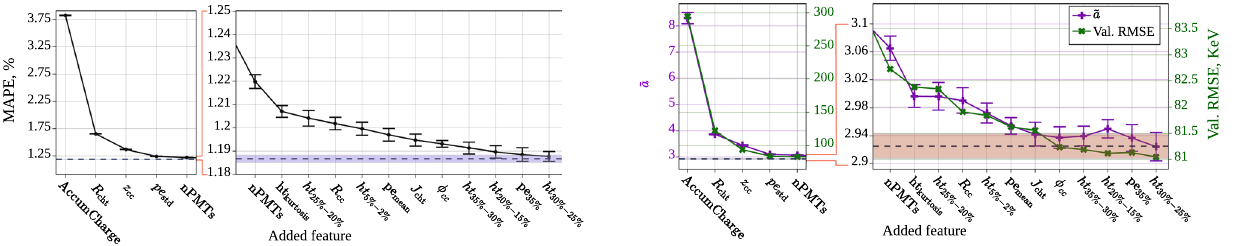
Fig. 9 Results of the feature selection procedure. Dashed line – aver- age MAPE for BDT trained on all features after CV with its standard deviation